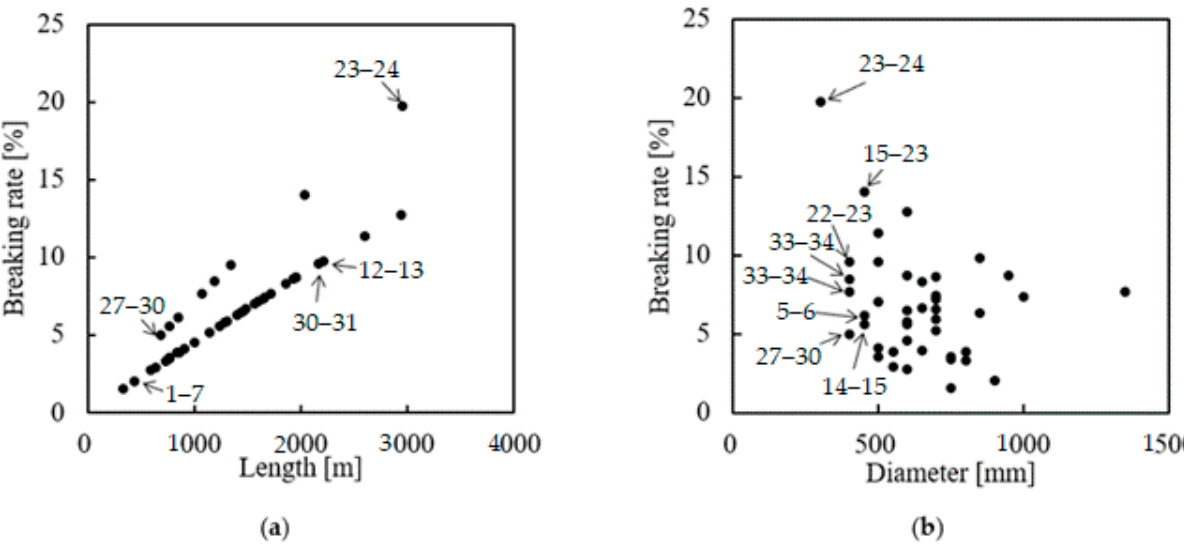
Figure 5. The relationship between breaking rates of water pipelines and their ( a ) lengths and ( b ) diameters. The numbers in each graph correspond to those of pipelines in Figure 3. The relationship of these three parameters is shown as a 3D graph in Figure S3 in Supplementary Materials.